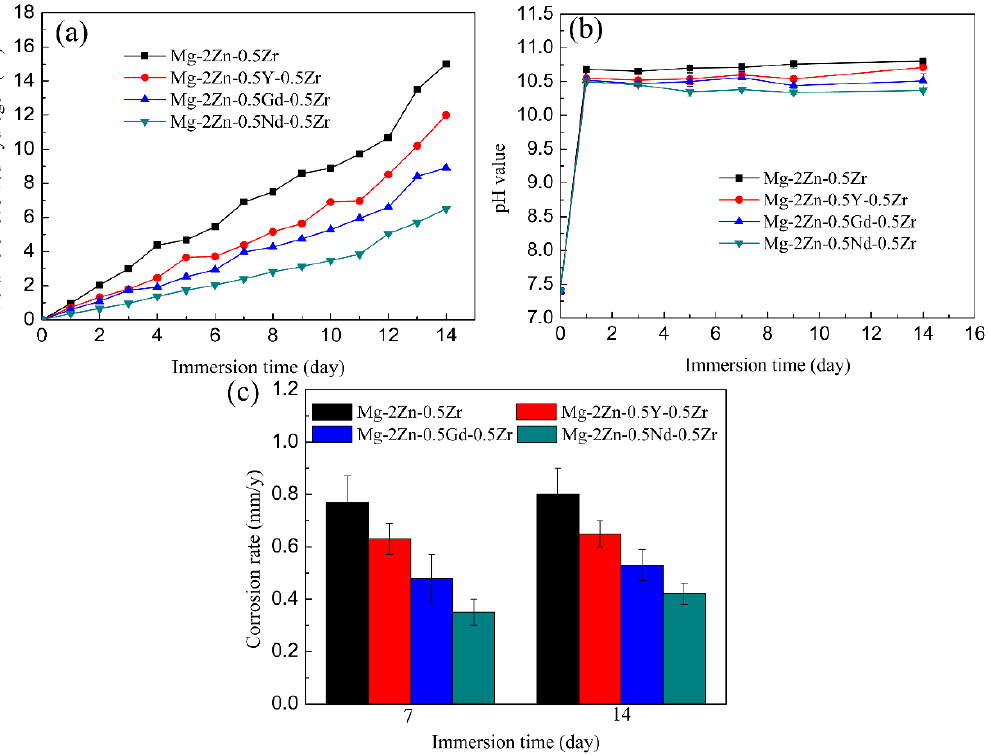
Figure 11. ( a ) H ydrogen evolution of the samples in Hank’s solution ; ( b ) pH value of the immersion Figure 11. ( a ) Hydrogen evolution of the samples in Hank’s solution; ( b ) pH value of the immersion solution; ( c ) corrosion rate after 7 days and 14 days of immersion. solution; ( c ) corrosion rate after 7 days and 14 days of immersion. Table 8. Chemical composition of the areas marked in Figure 10. Chemical Composition Position